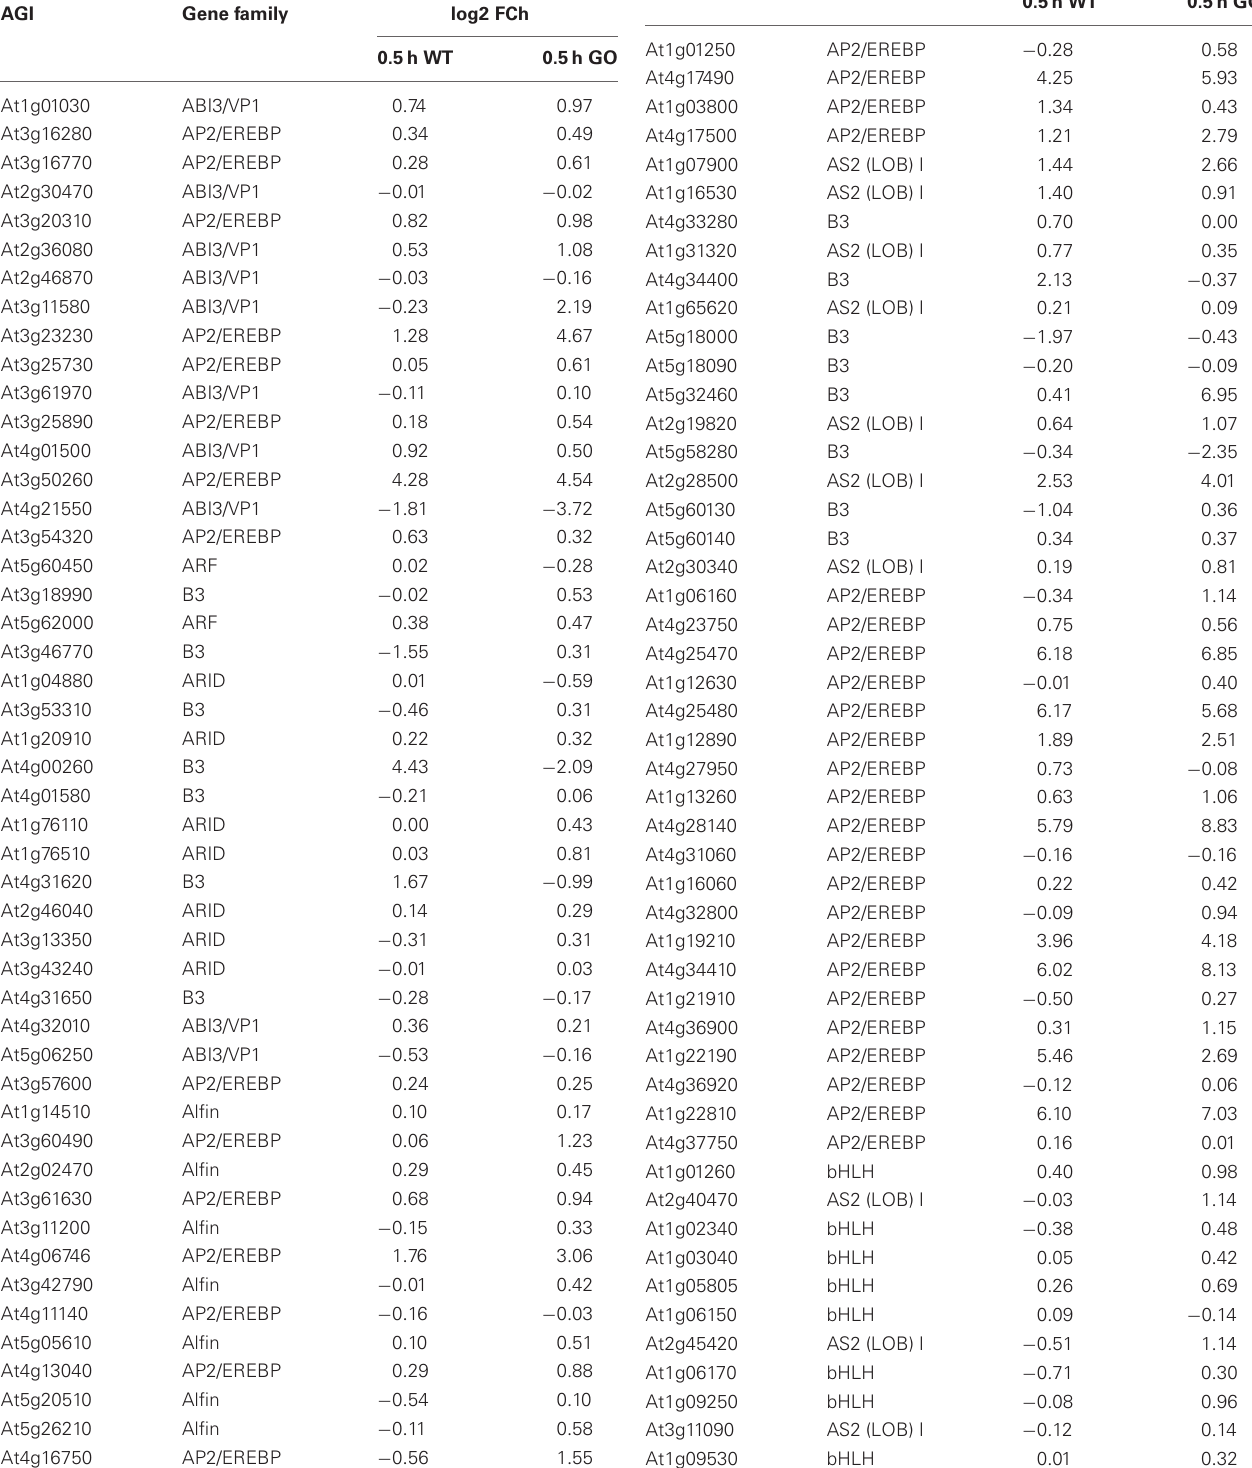
Table A2 | Numbers indicate log2 fold-change (FCh) expression ratio of genes after transferring plants to ambient CO 2 concentration compared to high CO 2